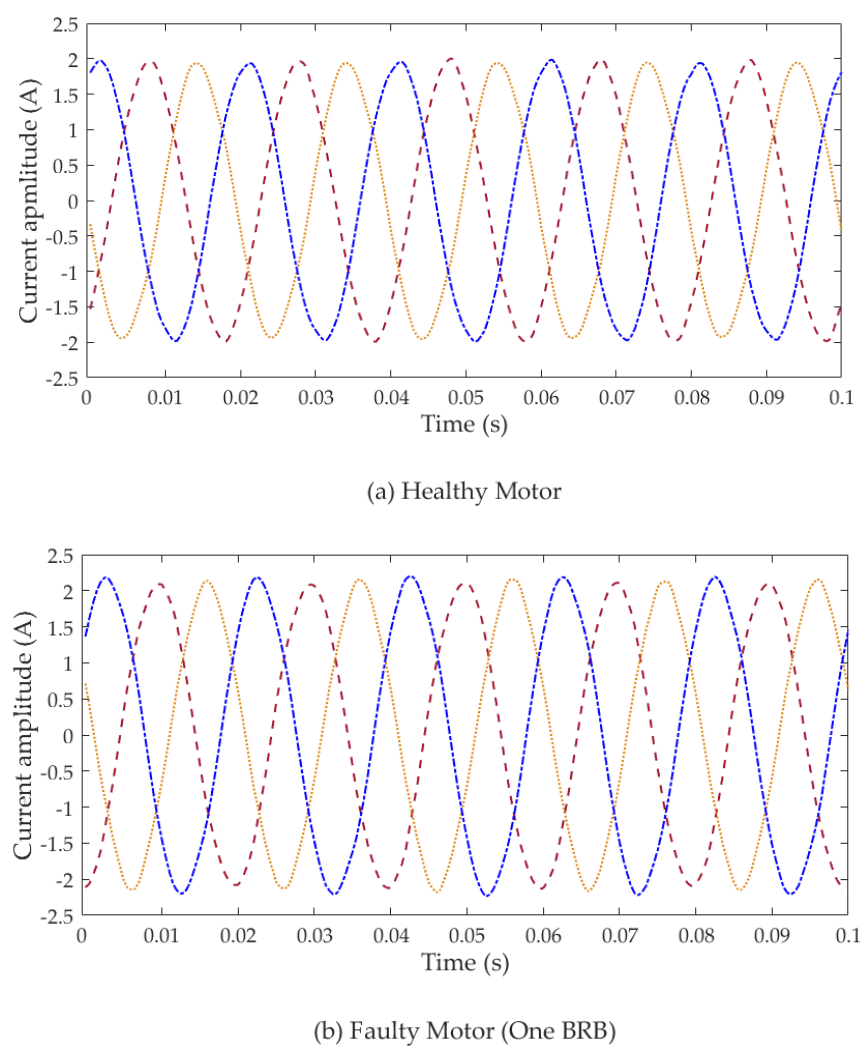
Figure 3. Typical motor current signal for 35% full-load ( a ) healthy motor and ( b ) motor with one broken bar.